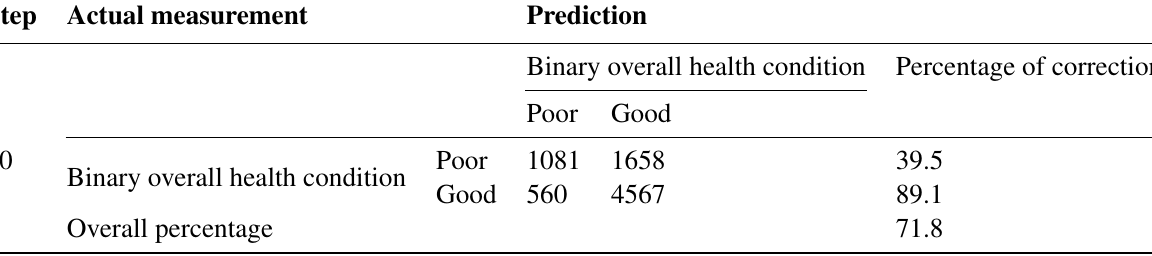
Table 4 Accuracy of the binary logistic regression